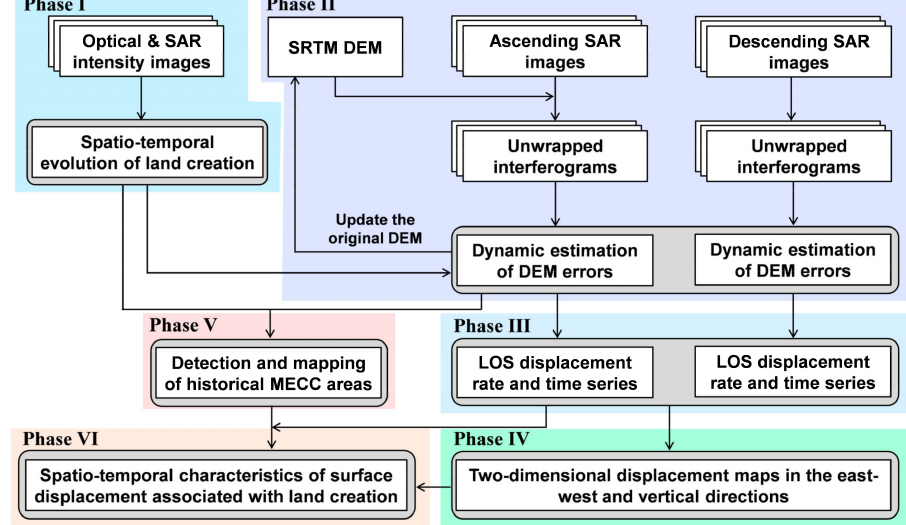
Figure 3. Workflow of the methodology adopted in this